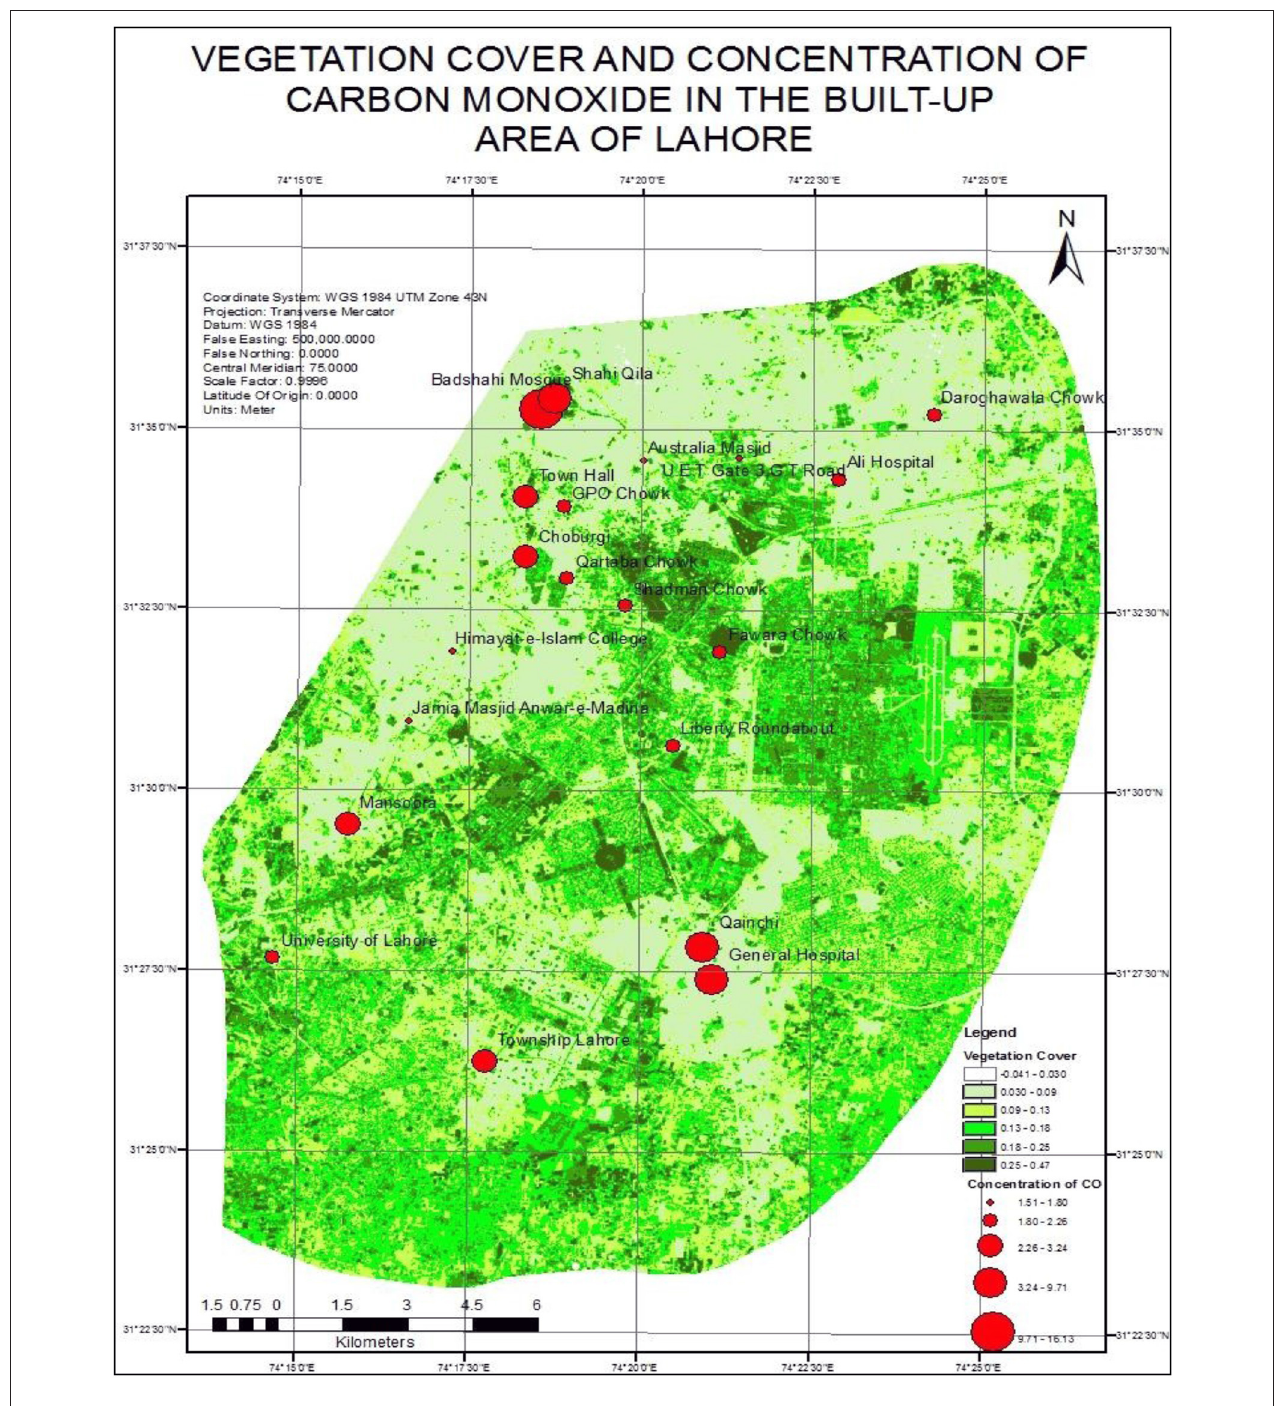
FIGURE 13 | Impact of vegetation and the concentration of carbon monoxide.